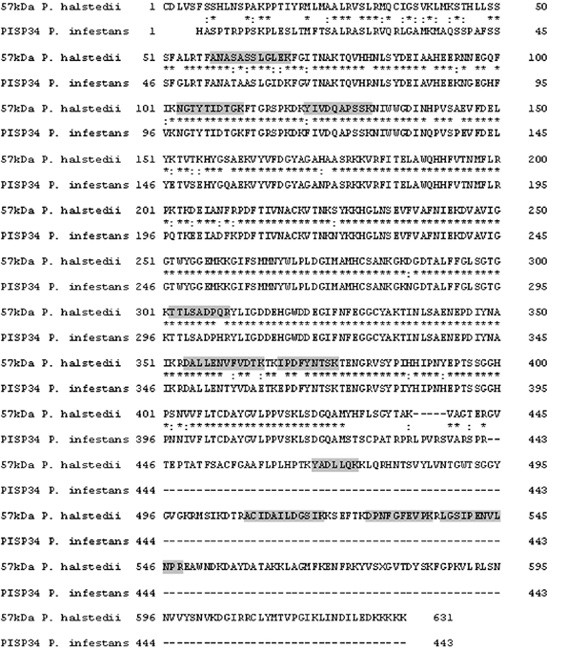
Homology alignment of P. infestans (putative phosphoenolpyruvate carboxykinase; PISP34) and P. halstedii 57 kDa protein. Partial alignment of PISP34 protein of P. infestans to the 57 kDa elicitor protein of P. halstedii is shown. Identity between both proteins amounts to 359 of 636 amino acids (56.4%). Asterisks (*) denotes homology and colon (:) denotes similarity of amino acids. Boxed letters (grey) mark de novo sequenced peptide candidates as shown in table 2.